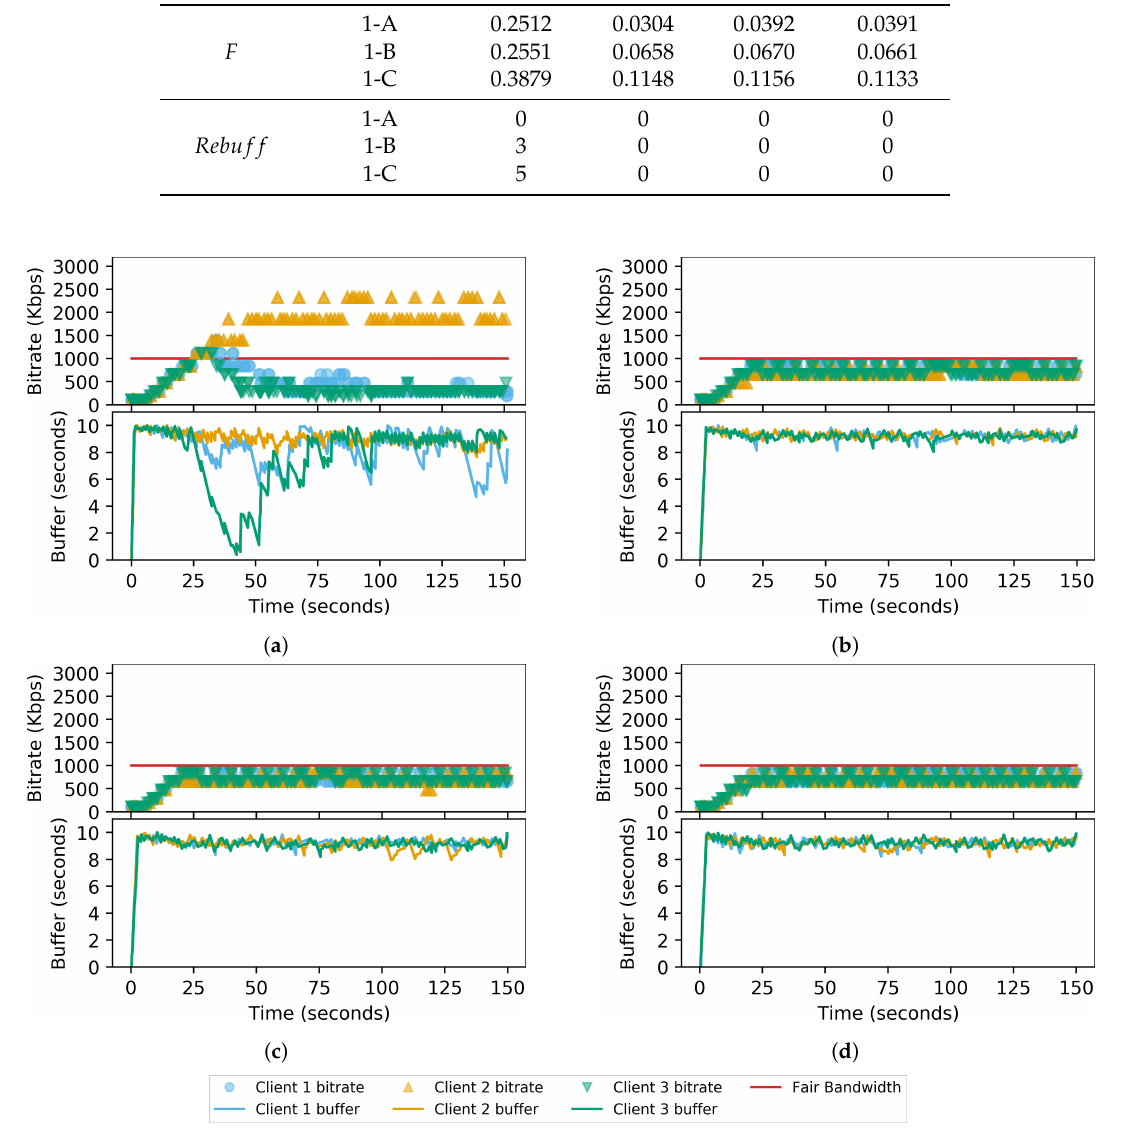
Figure 5. Time-varying performances of all methods in scenario #1. ( a ) No-Proxy; ( b ) Reactive; ( c ) Proactive; ( d )